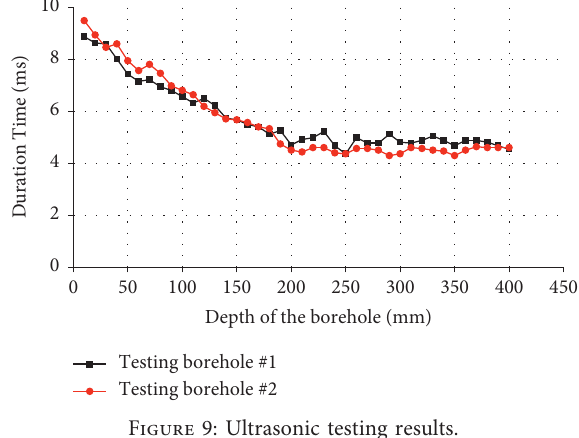
Figure 9: Ultrasonic testing